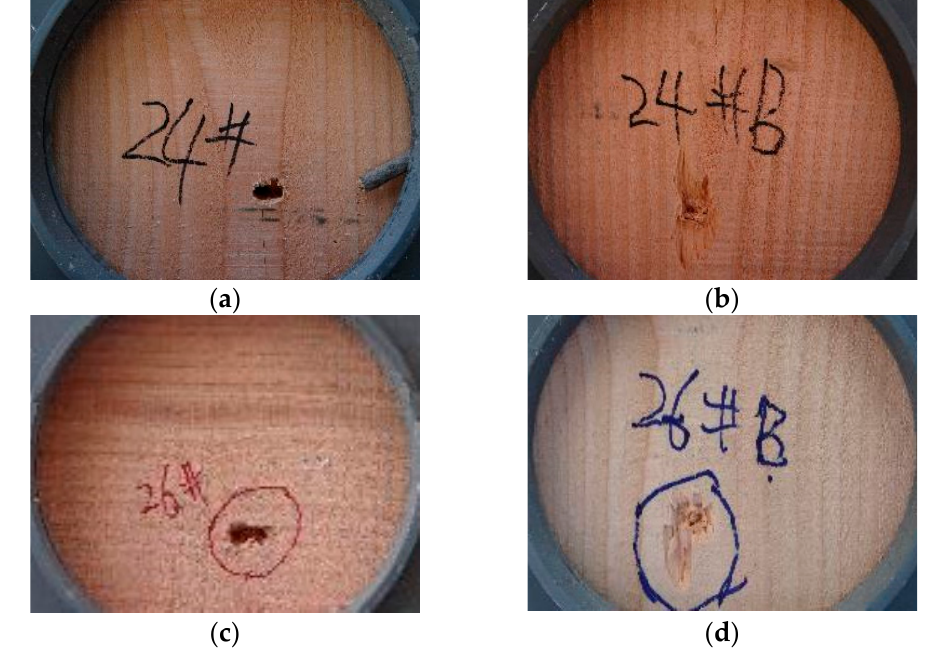
Figure 3. Failure of wood target at two speeds. ( a ) is 965 m/s frontal failure; ( b ) is 965 m/s back failure; ( c ) is 1363 m/s frontal failure; ( d ) is 1363 m/s back failure.